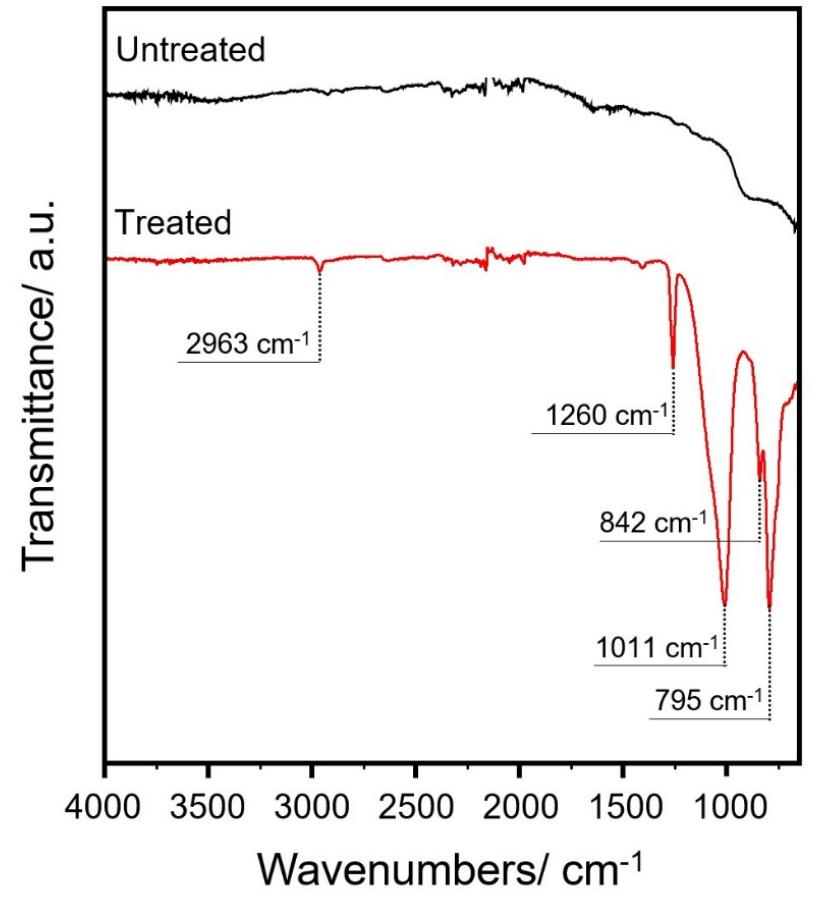
Figure 2. FT-IR spectra (cm − 1 ) of untreated stainless steel disks and treated with nanoXHAM ® D